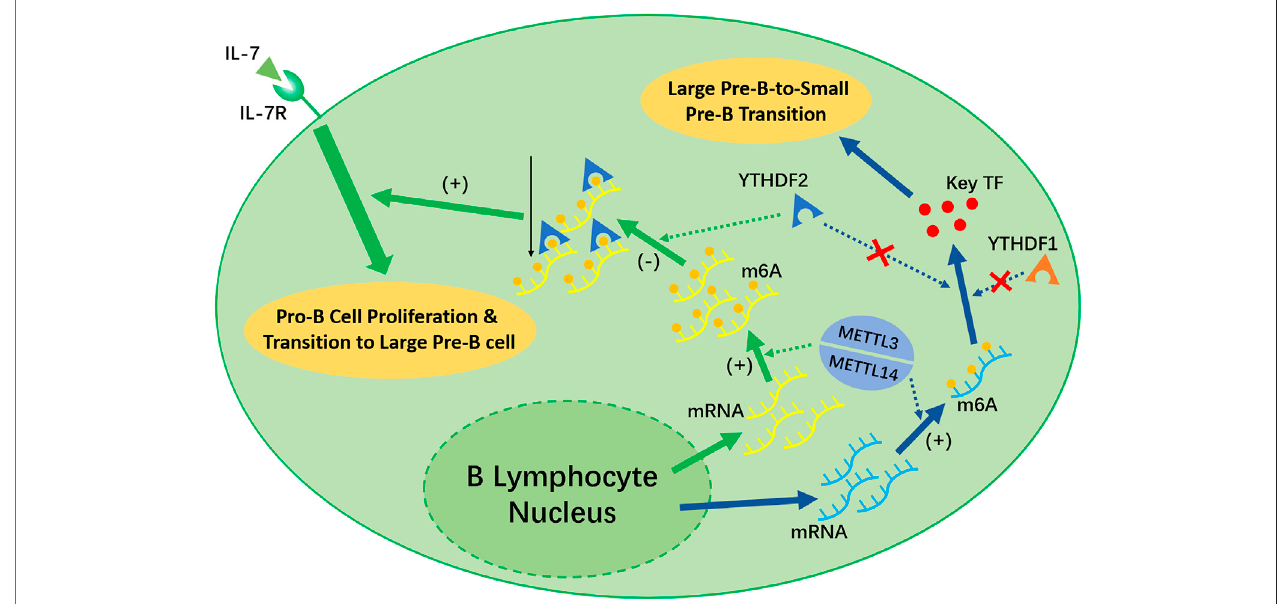
FIGURE 3 | METTL3/METTL14 complex and YTHDF1 is necessary for the early development of B lymphocytes. METTL14 plays an unreplaceable role in the IL-7 induced Pro-B lymphocyte proliferation, Pro-B-to-Large-Pre-B transition, and Large-Pre-B-to-Small-Pre-B transition. YTHDF2 will recognize the m 6 A modi fi cation afterwardsanddecreasethetranscriptsasaresult, whichpromoteearlyBlymphocyte development.Notably,YTHDF2onlyfacilitateinthe fi rsttwoprocess.TheLarge- Pre-B-to Small-Pre-B Transition is independent of YTHDF1 or YTHDF2.